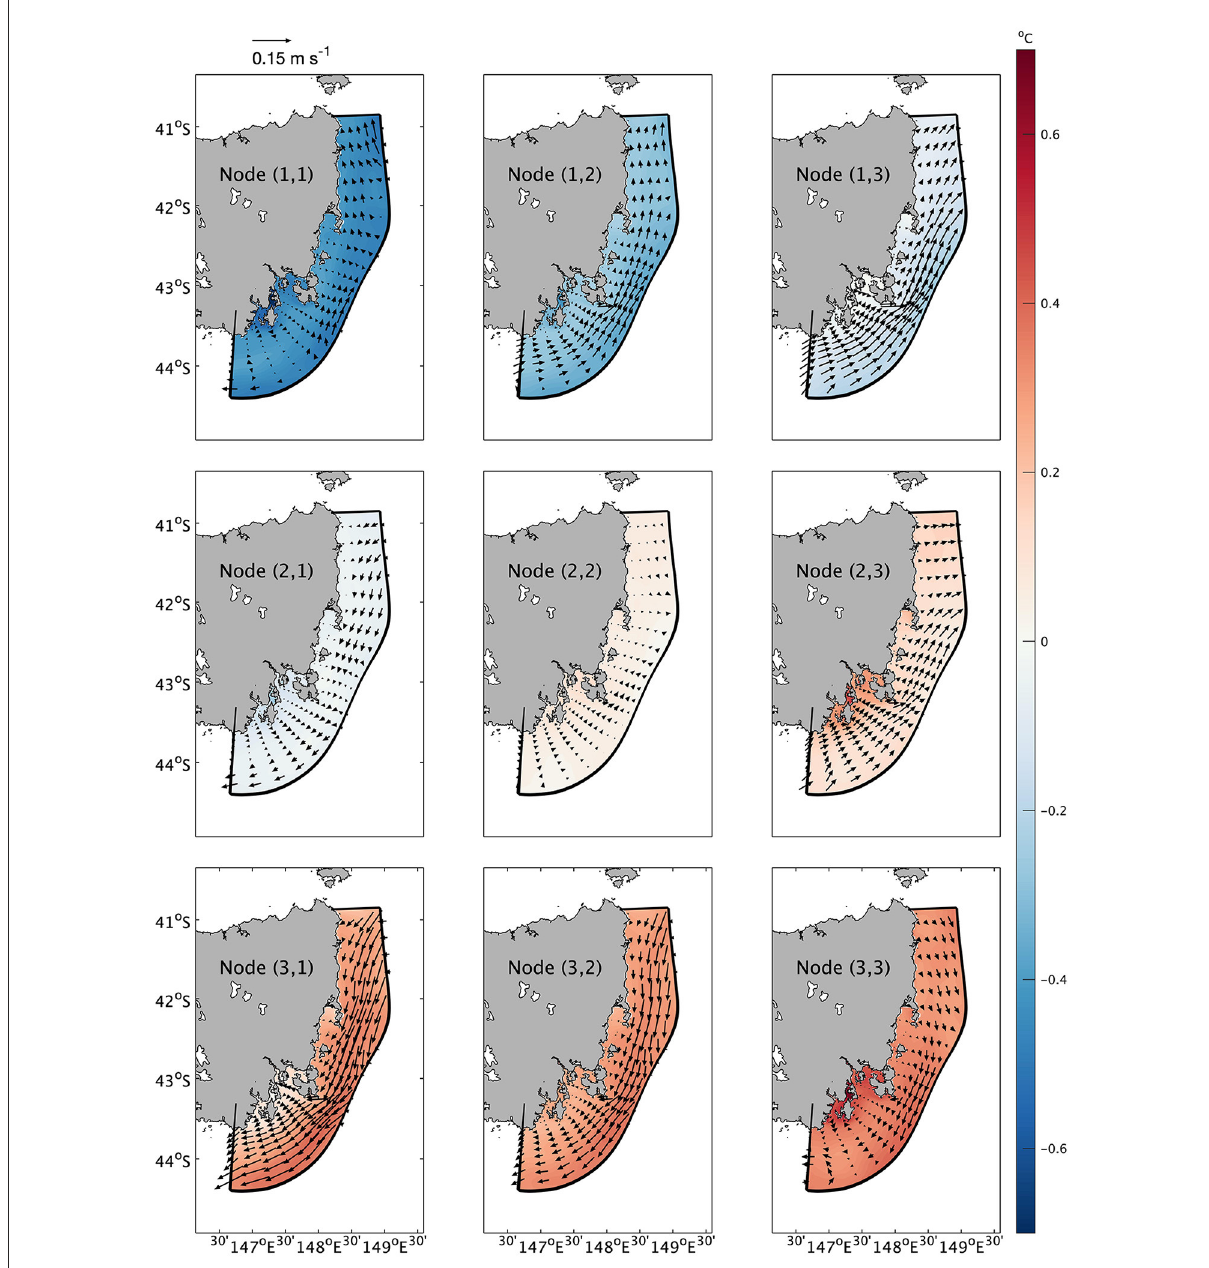
FIGURE4 The mean oceanic states in each node. Colors (arrows) indicate the temporally averaged temperature (current) anomalies across all eddies in this node.